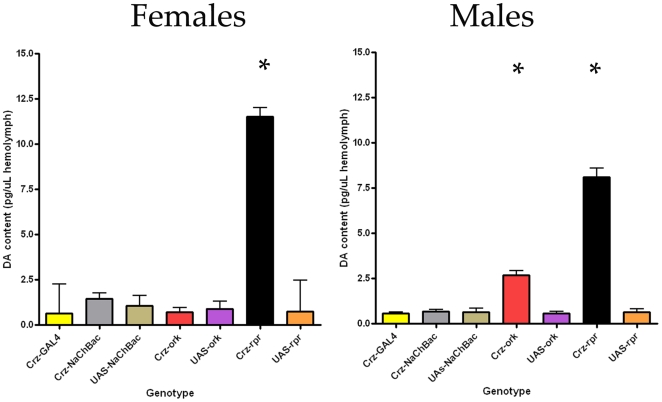
Corazonin neuronal alterations impact the levels of dopamine.Dopamine concentrations as determined by HPLC measurements on hemolymph derived from males and females with varying corazonin phenotypes. For females, only the Crz-rpr lines significantly differed in dopamine levels compared to all other control genotypes (P<0.05, Tukey's Post Test for means). In males, both the Crz-rpr and Crz-ork lines were significantly different than control parental genotypes.